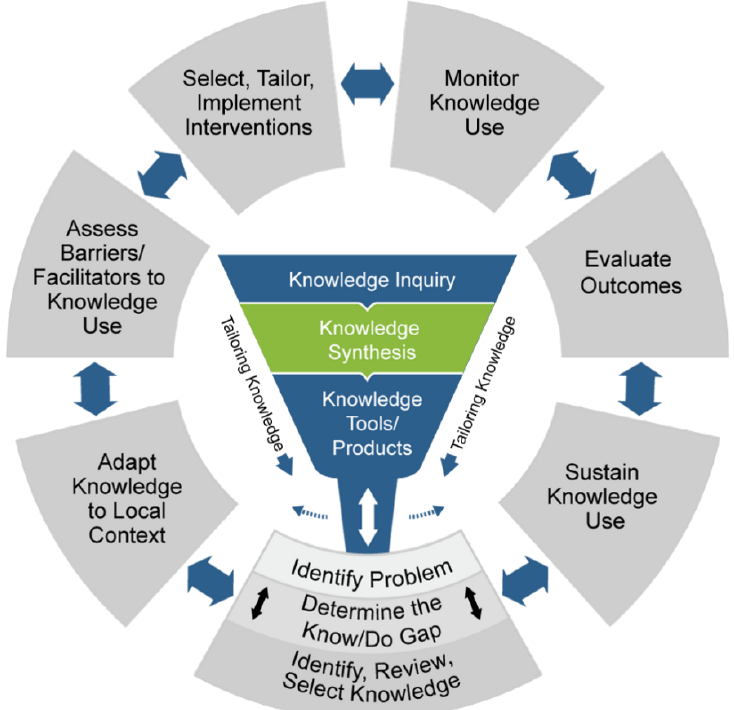
Figure 1. The Knowledge to Action Framework [20] . Re-printed with permission from the publisher (Wiley). lisher